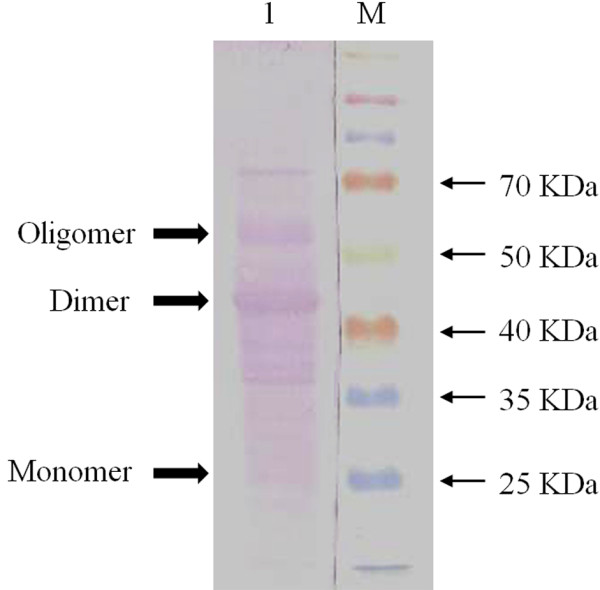
Western blot of cell disrupted samples using optimized conditions by high pressure homogenizer. Lane M represents protein marker, lane 1 represents cell disrupted sample. Western blot was performed using the same monoclonal anti-HBsAg as ELISA assay.